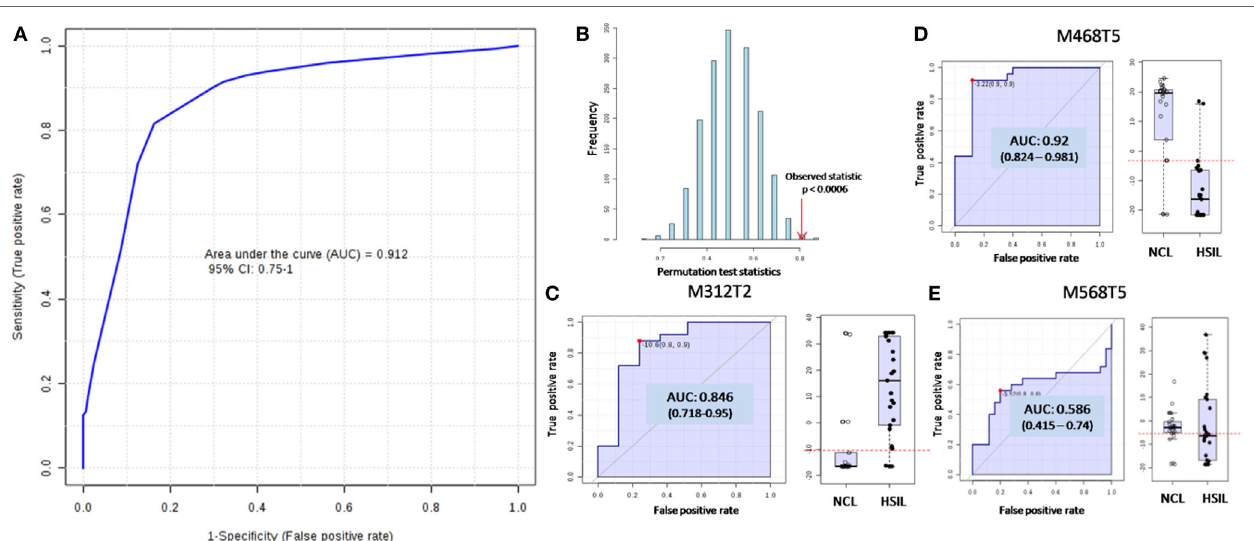
FigUre 2 | Supporting vector machine (SVM) model for differentiation of high-grade squamous intraepithelial lesions ( HSIL ) group and no cervical lesion ( NCL ) group according to their metabolomics and clinical evaluation at collection time. (a) The receiving operating-characteristic (ROC) curve ploting the true positive rate against the false positive rate for the model as a whole, which displayed an area under the ROC curve (AUC) of 0.91 for the test set, with average accuracy of 80.9%, based on 100 cross validations. (B) The p -value was found to be significant since it is less than 0.05. The individuals ROC for the three molecules used for building the model and the relative abundances distribution of these molecules over the groups shown by the box-plots are displayed for M312T2 (c) , M468T5 (D) , and M568T5 (e)